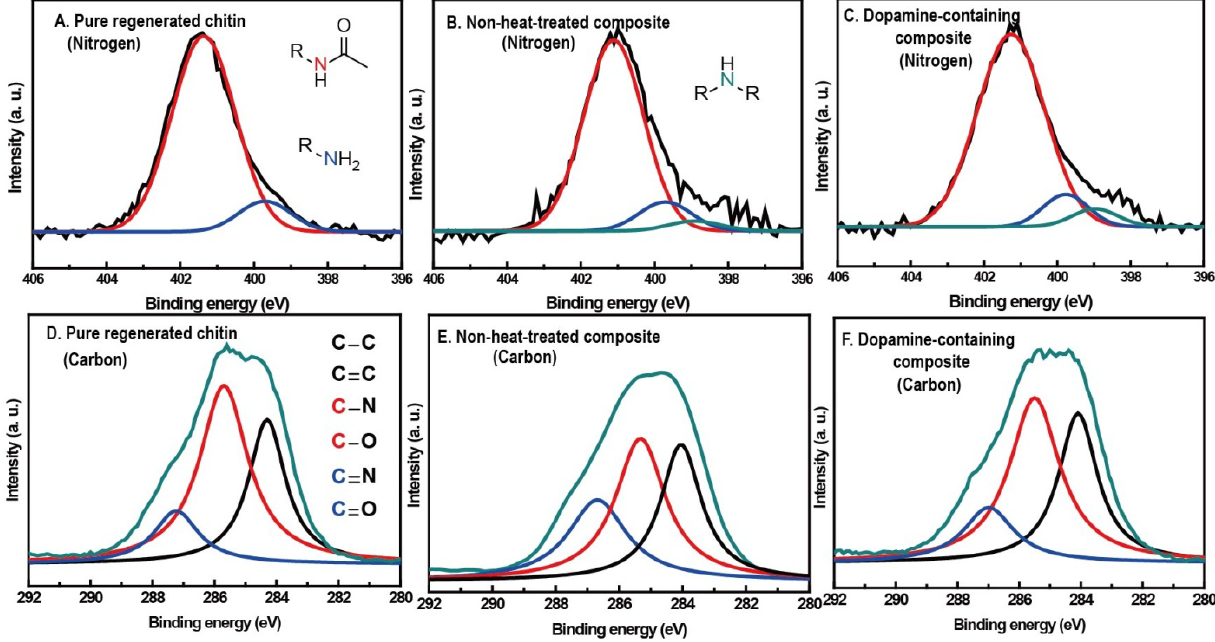
Figure 1. Nitrogen 1s narrow scans in X-ray photoelectron spectroscopy (XPS) spectra